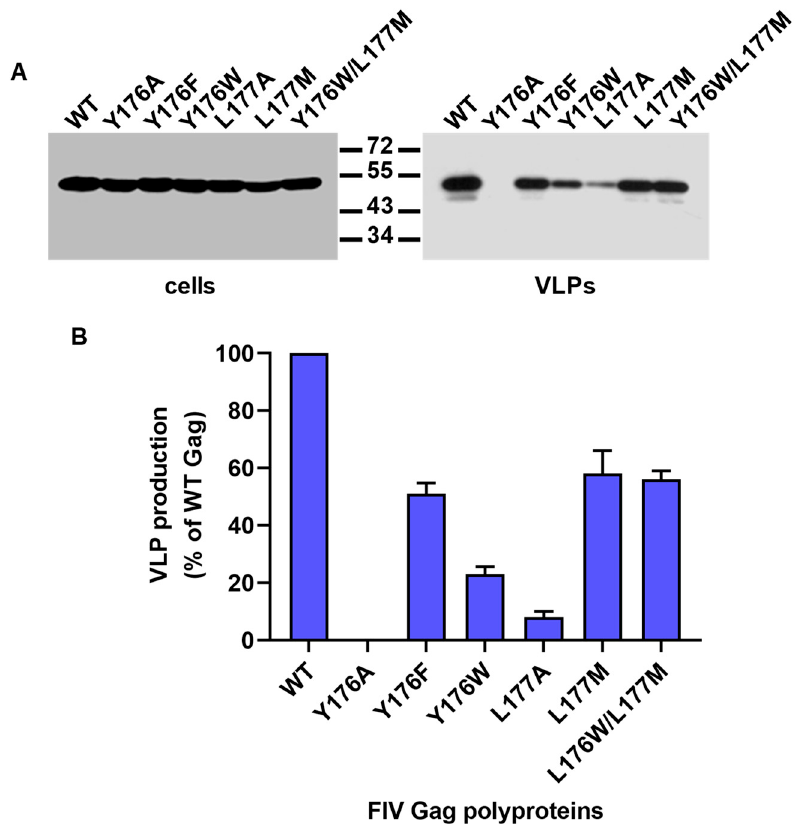
Figure 2. Assembly of FIV Gag mutants into VLPs. ( A ) COS-7 cells were first infected with the vTF7-3 recombinant vaccinia virus, and then transfected with the plasmids directing the expression of wild-type (WT) or the mutant Gag polyproteins. Cells were harvested 30 h post-transfection, and the VLPs were purified from the clarified culture supernatants as described in Materials and Methods. The presence of Gag proteins in cell and VLPs lysates was analyzed by Western blotting using the anti-FIV CA MAb. Numbers indicate the positions of the molecular weight standards (in kDa). The results are representative of three independent experiments. ( B ) The amount of each Gag mutant polyprotein in the VLPs fraction was quantitated and referred to that purified from the clarified supernatant of cells expressing wild-type Gag (considered as 100%). Data presented are the mean of three independent experiments ± the standard deviation.